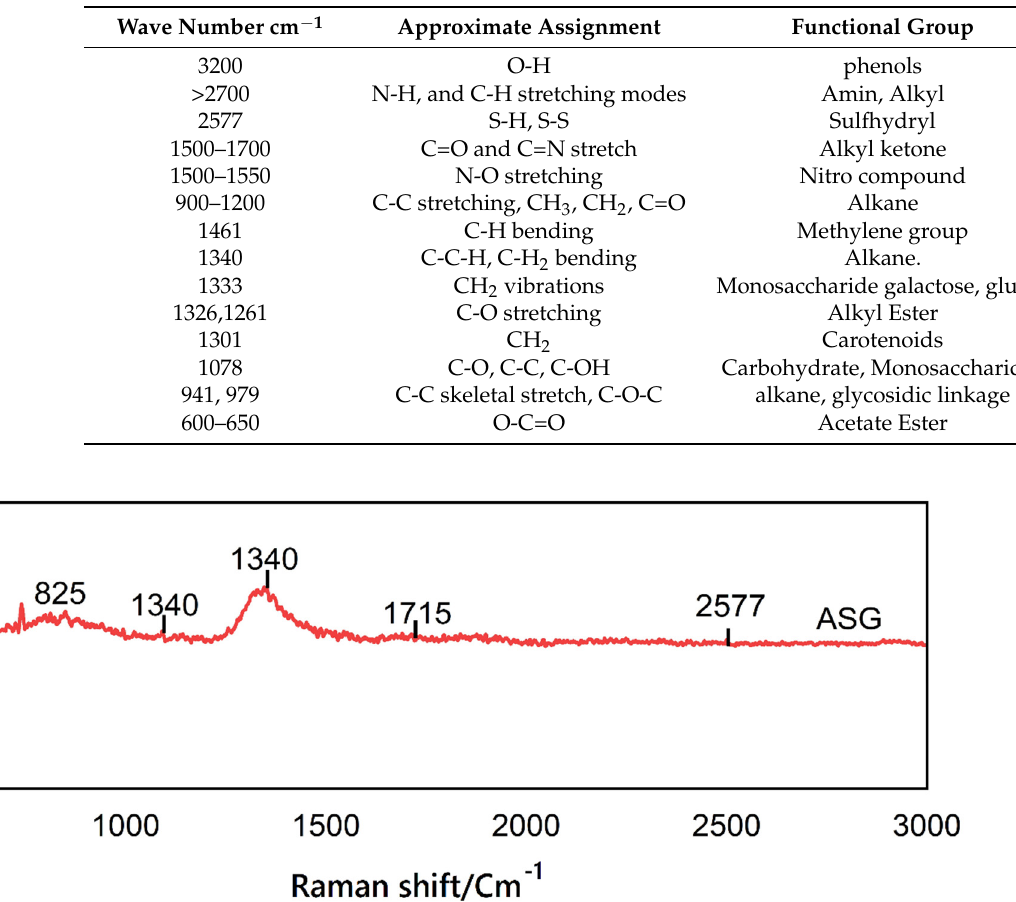
Table 5. Functional groups assigned peaks of Acacia Seyal gum using Raman spectroscopy.